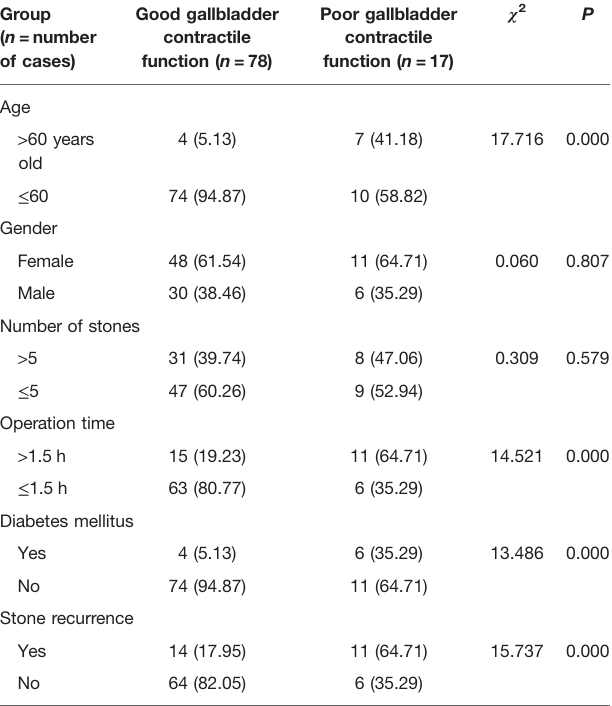
TABLE 3 | Factors affecting the changes of gallbladder contractile function.